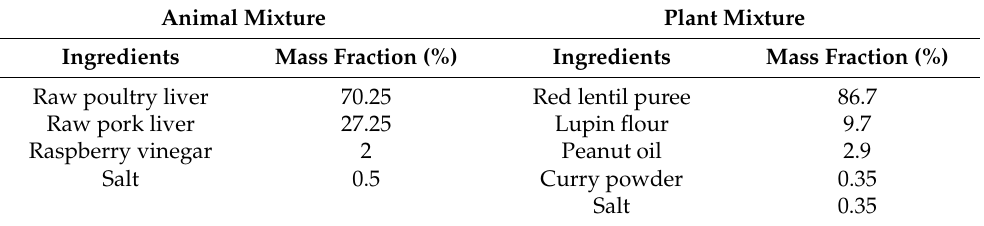
Table 1. Composition and quantities of ingredients used for each part of the 3D-printed hybrid foods. Animal